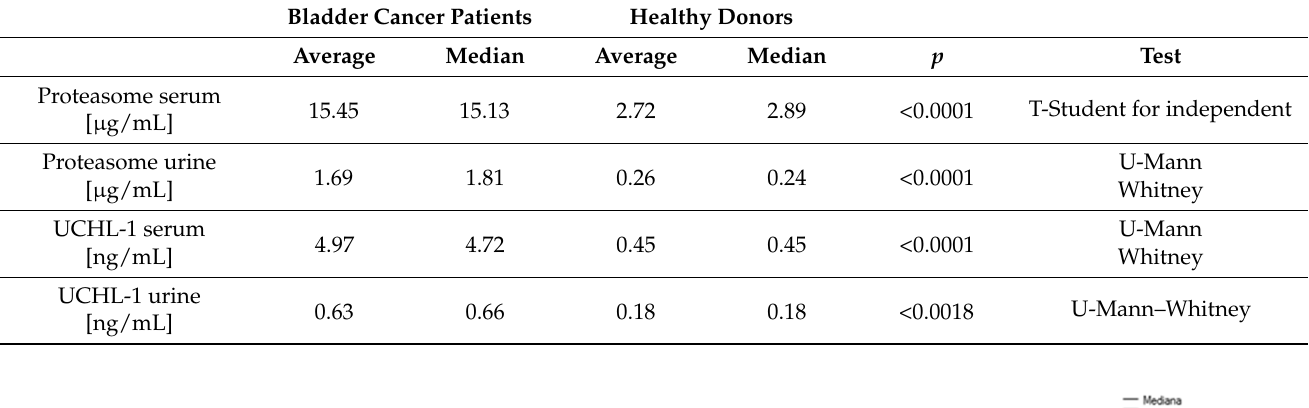
Table 2. Concentrations of 20S proteasome and UCH-L1 in the examined samples.